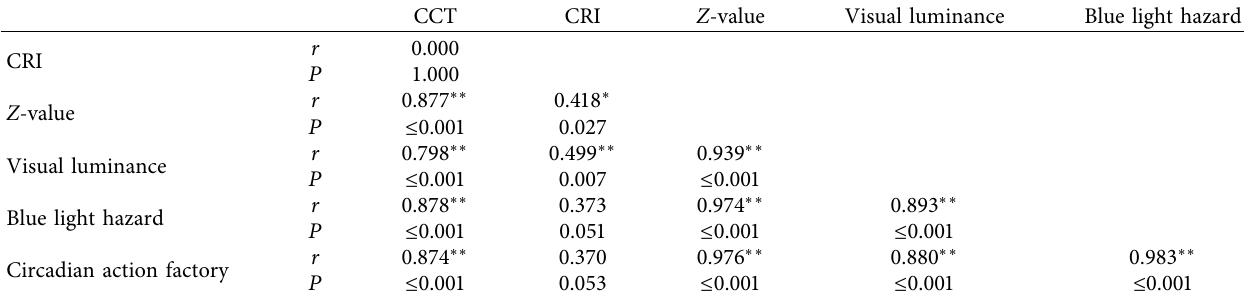
Table 4: Significance analysis for the above